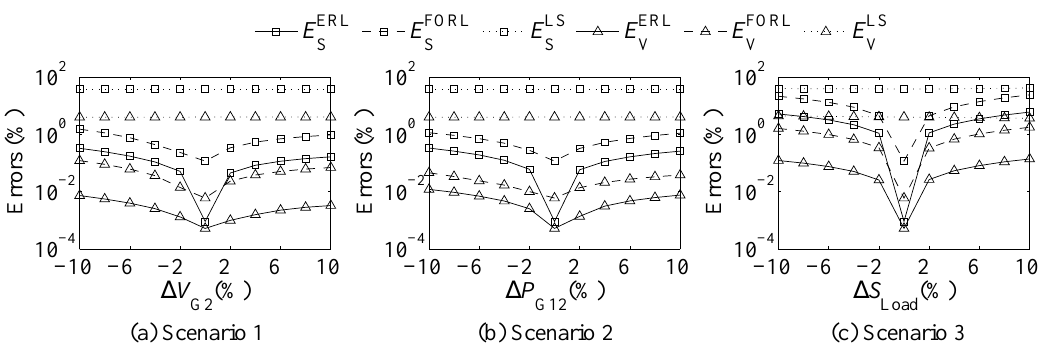
Figure 10. Relative errors produced by the three algorithms in the different scenarios.